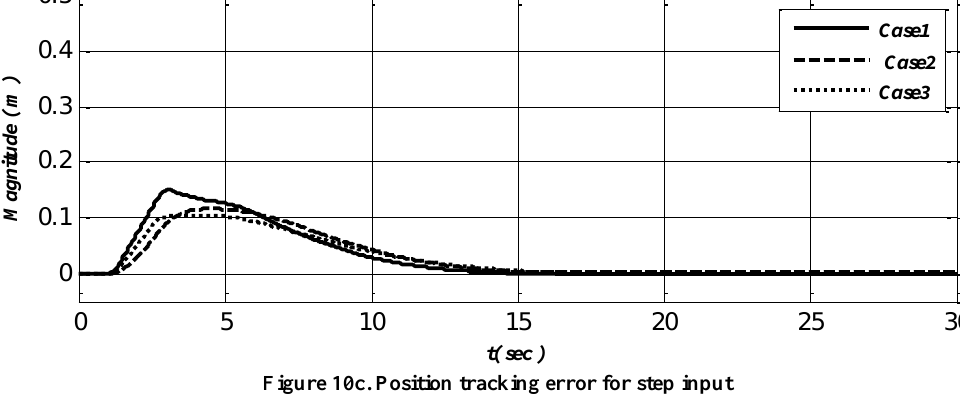
Figure 10c. Position tracking error for step input